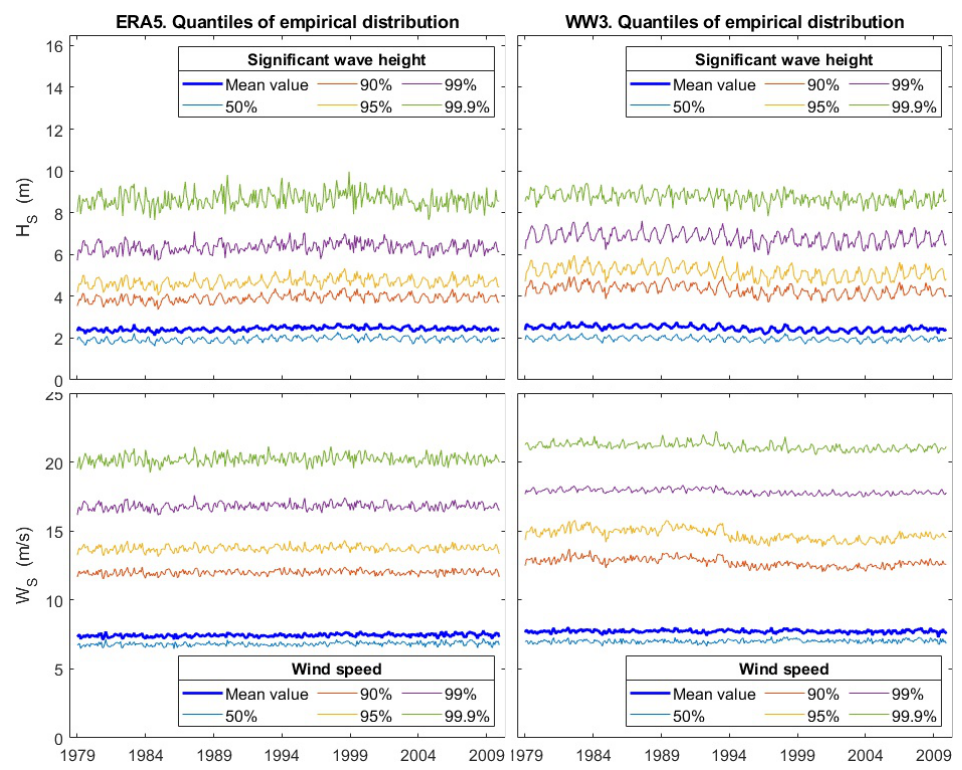
Figure 5. Monthly quantiles 50% (median), 90%, 95%, 99%, and 99.9% taking into account all datapoints ( left : ERA5, right : WW3, top : significant wave height, bottom : wind